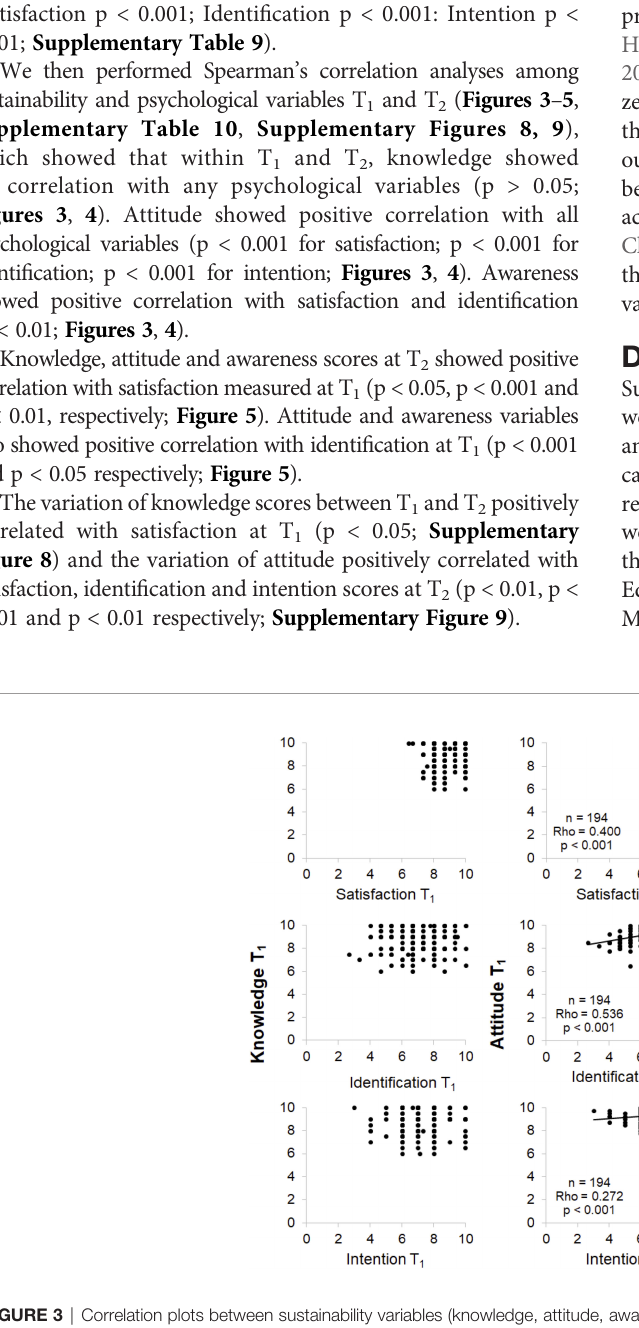
FIGURE 3 | Correlation plots between sustainability variables (knowledge, attitude, awareness) and psychological variables (satisfaction, identi fi cation, intention) at T 1 . Only signi fi cant (p<0.05) regressions are drawn. n: number of participants; Rho: Spearman ’ s rank correlation coef fi cient; p: